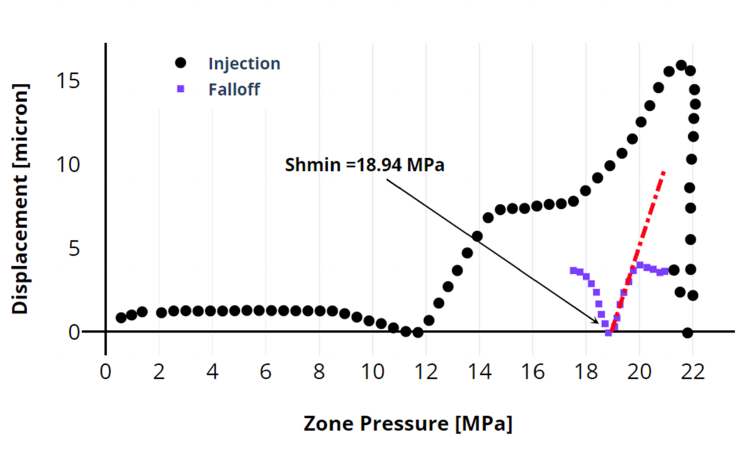
Figure 22. SIMFIP displacement versus zone pressure for test 4 (Modified from